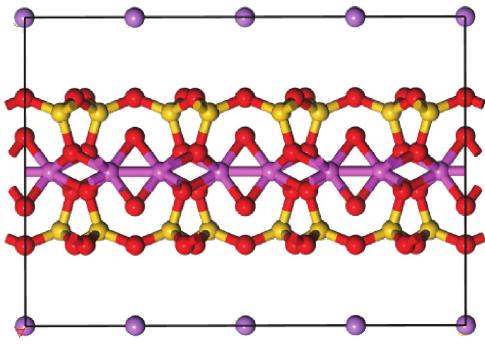
Figure 6: Unit cell of montmorillonite.